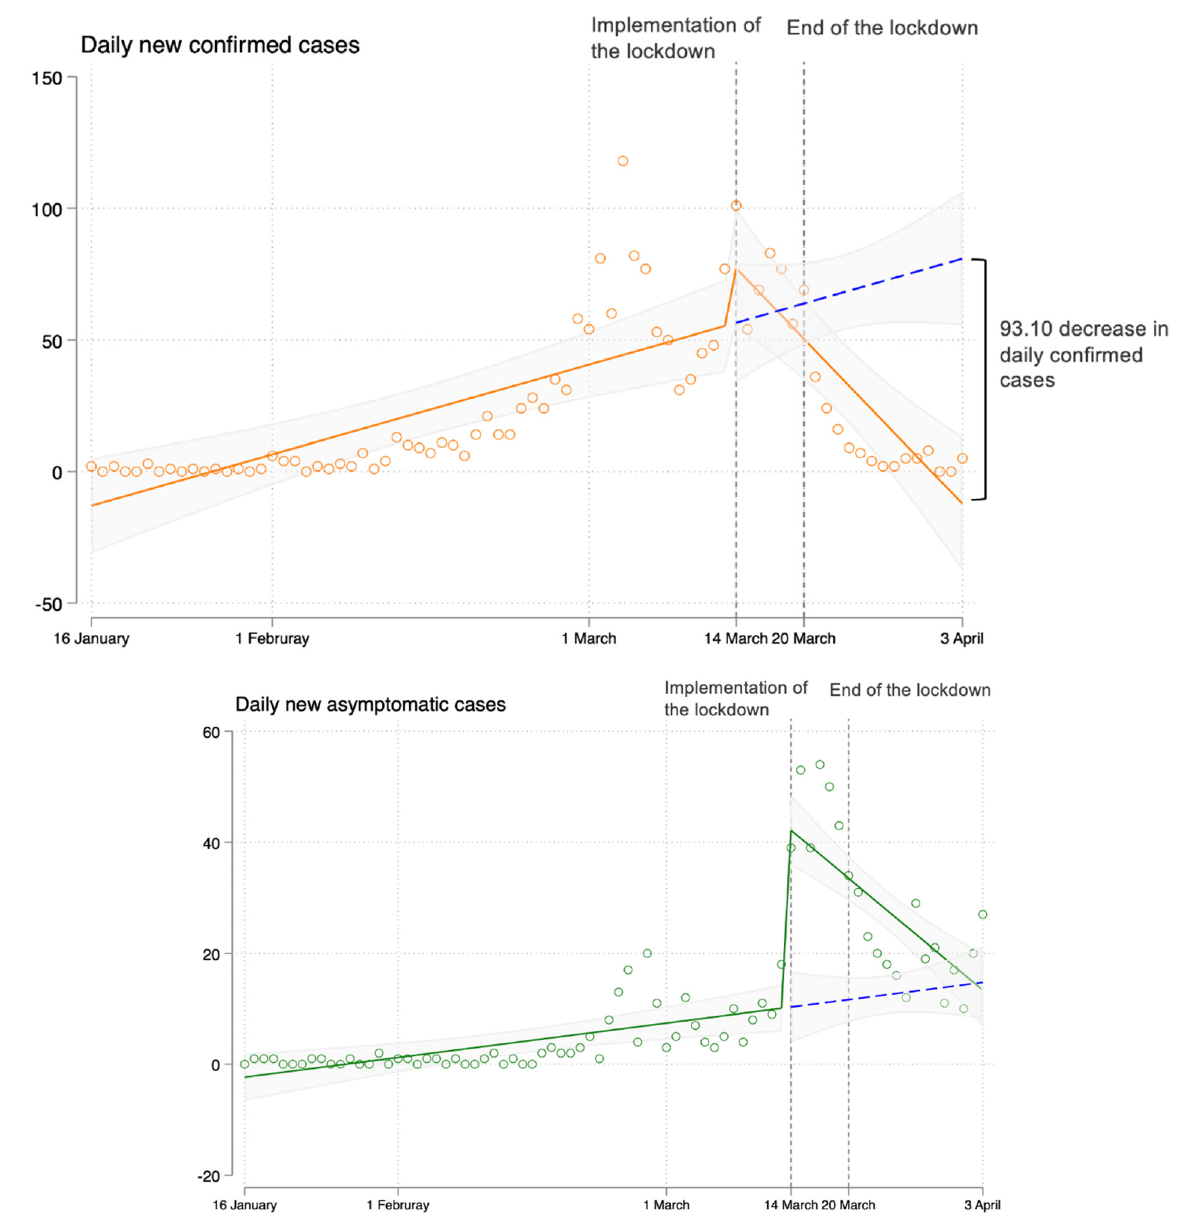
Figure 1. Trends in daily new confirmed cases and asymptomatic cases before and after the imple- mentation of lockdown in Shenzhen, China, 16 January to 3 April 2022.